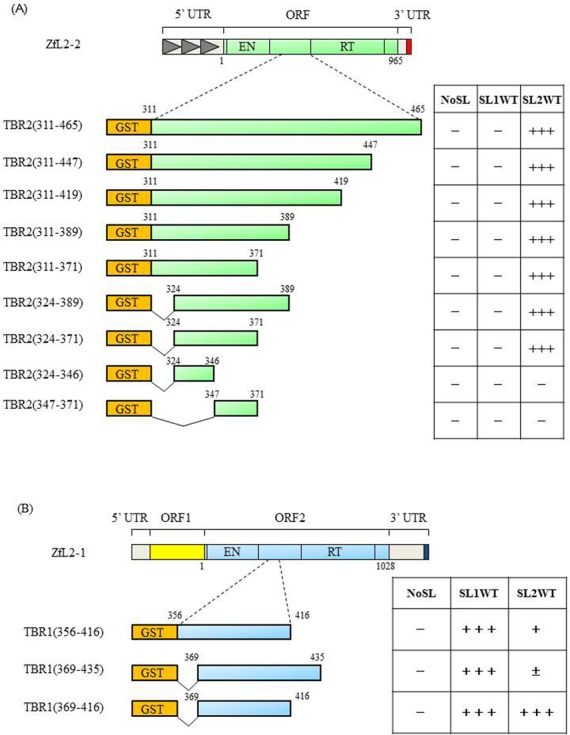
TBR1p and TBR2p bind to their respective cognate stem-loop RNA. Schematic representation of TBR corresponding to ZfL2-2 (A) or ZfL2-1 (B) protein used for the binding assay. Numbers indicate amino acid residue positions. Each (+) indicates that the protein could bind the RNA, and each (–) indicates no RNA binding, i.e. the binding was the same as that for the RNA lacking the stem-loop (NoSL). (±) indicates that there was no significant difference statistically, although the binding activity of SL2WT of TBR1(369–435)p is higher than that of NoSL. At least three independent experiments were done for each protein.